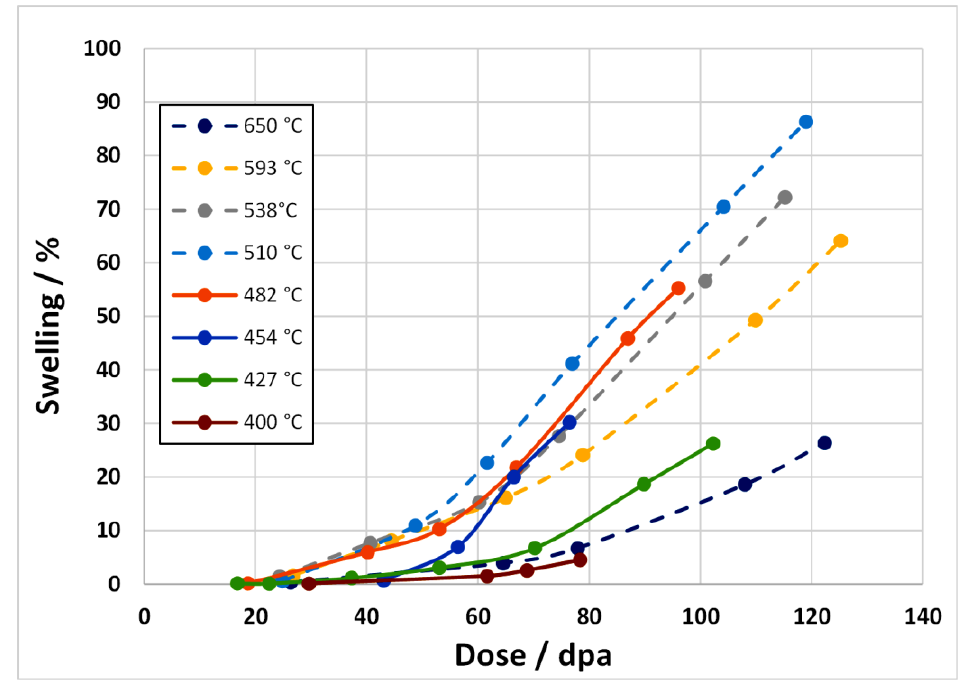
Figure 22. Swelling determined by density change as a function of irradiation temperature and dose, as observed in 20% cold-worked AISI 316 irradiated in the EBR-II fast reactor. All measurements at a given temperature were made on the same specimen after multiple exposures with subsequent reinsertion into the reactor. This procedure minimized specimen-to-specimen data scatter and assisted in a clear visualization of the post-transient swelling rate. Modified from [3].